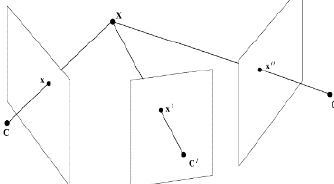
Figure 9. Trifocal model generated with PhotoScan.